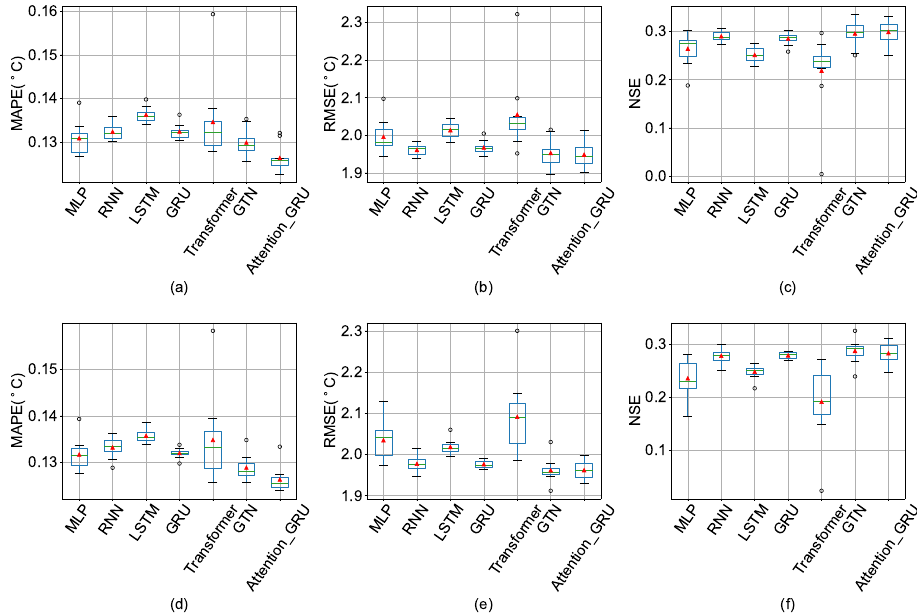
Figure 6. The box plot of ten experiment results of deep learning models under linear interpolation and cubic spline interpolation. ( a – c ) are the results of evaluation indexes under linear interpolation method, respectively; ( d – f ) are the results of evaluation indexes under Cubic spline interpolation method, respectively. In the boxplot, the horizontal lines (from bottom-up) represent the minimum, first quartile, median, third quartile, and maximum, respectively. The circles represent outliers, and the red triangle represents the average of the experimental results.